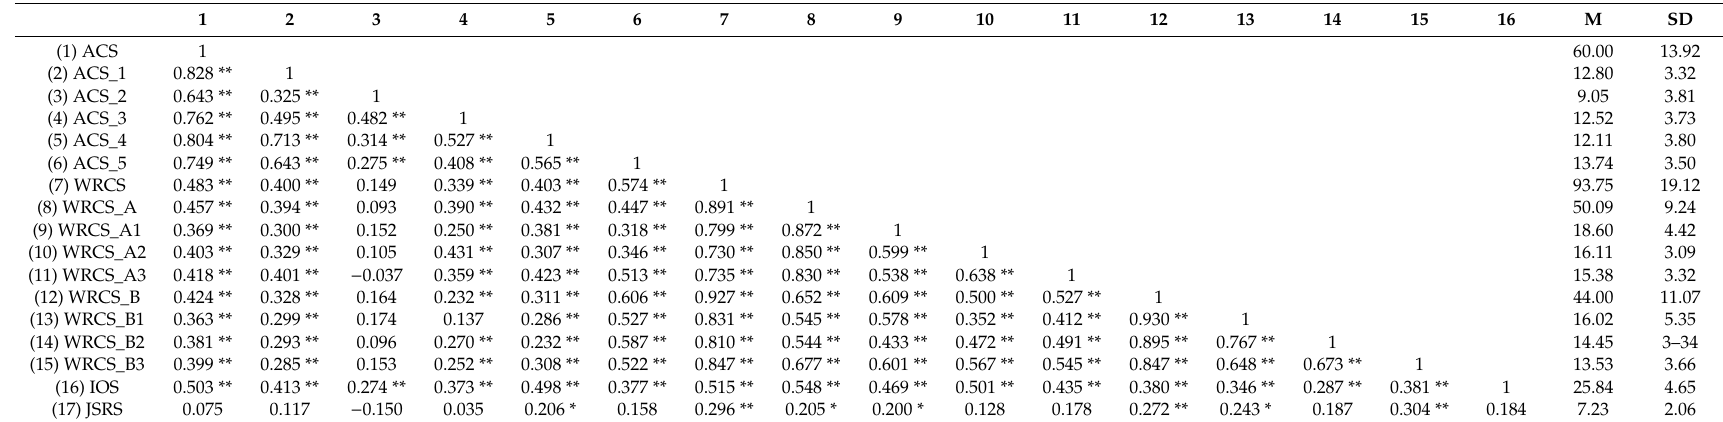
Table 2. Bivariate correlations and descriptive statistics of the